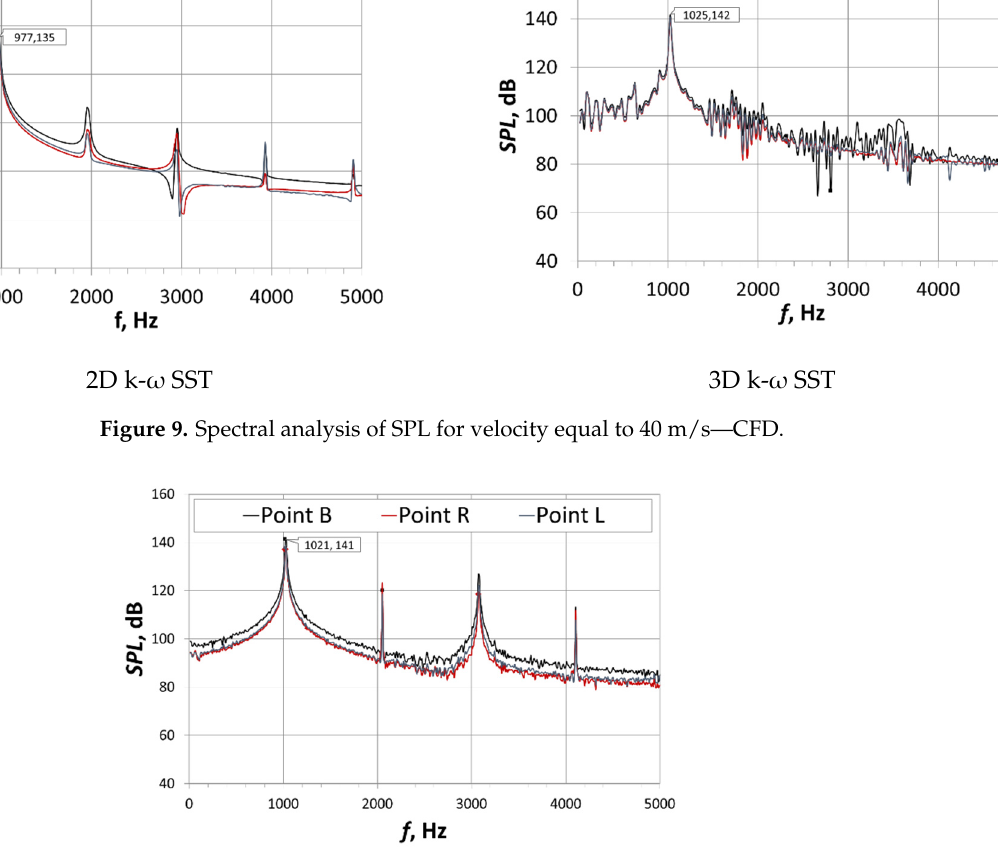
Figure 10. Spectral analysis of SPL for velocity in the channel equal to 40 m/s—experimental data.